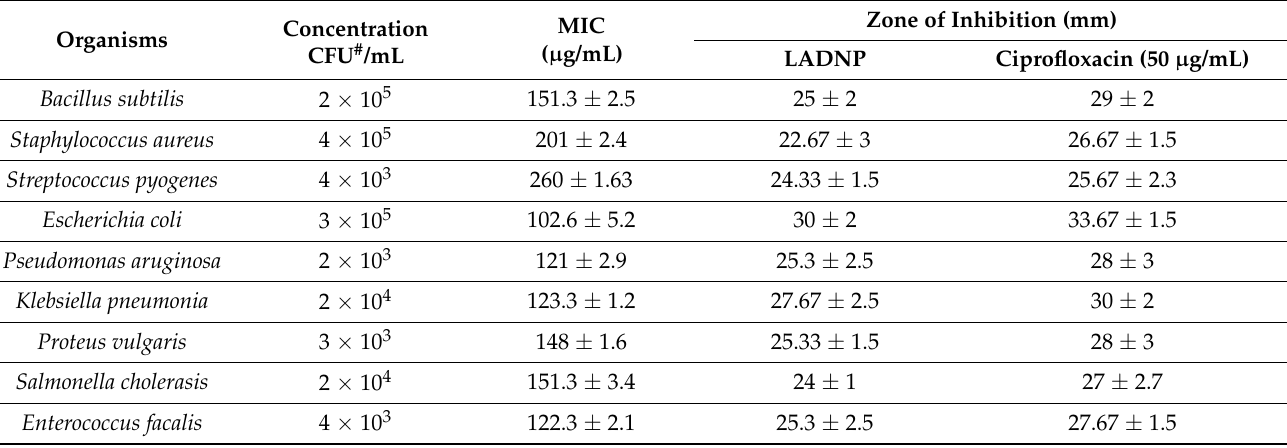
Table 2. Antibacterial study.